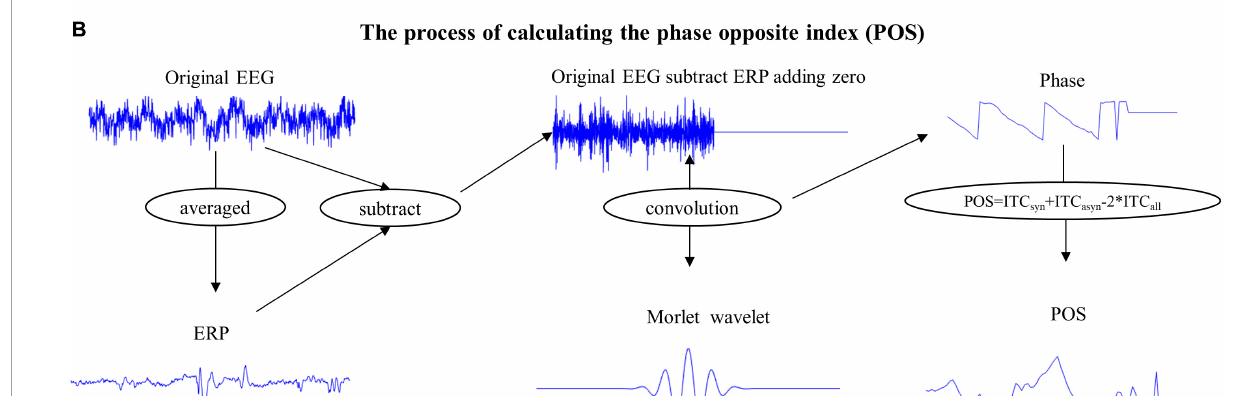
ERP. Then we subtracted the ERP from the original EEG signal on each trial to get the ongoing neural